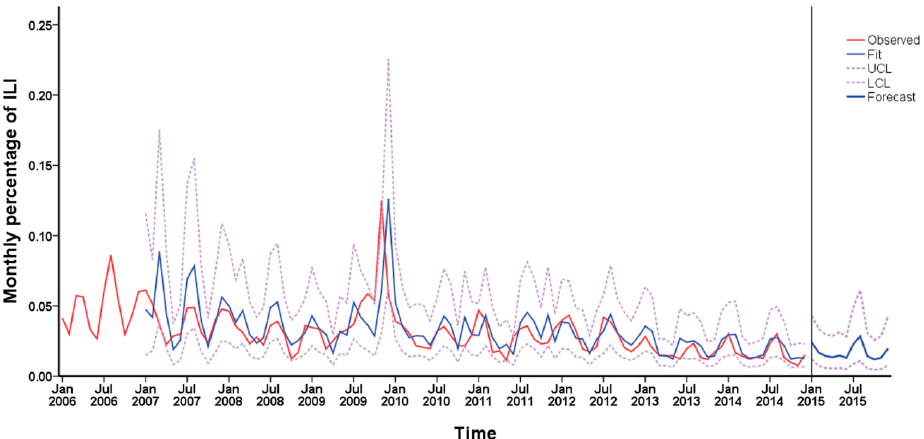
Figure 5. Time series profile for the prediction of influenza by the autoregressive integrated moving average (ARIMA) (1, 1, 1) (1, 1, 0) 12